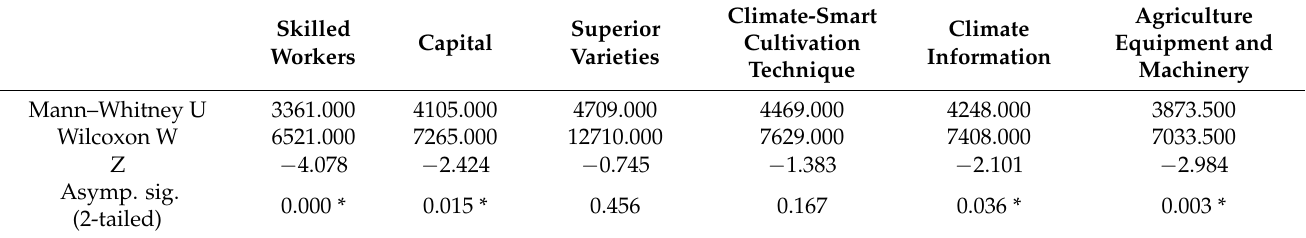
Table 6. Input barriers to implementing CSA practices.